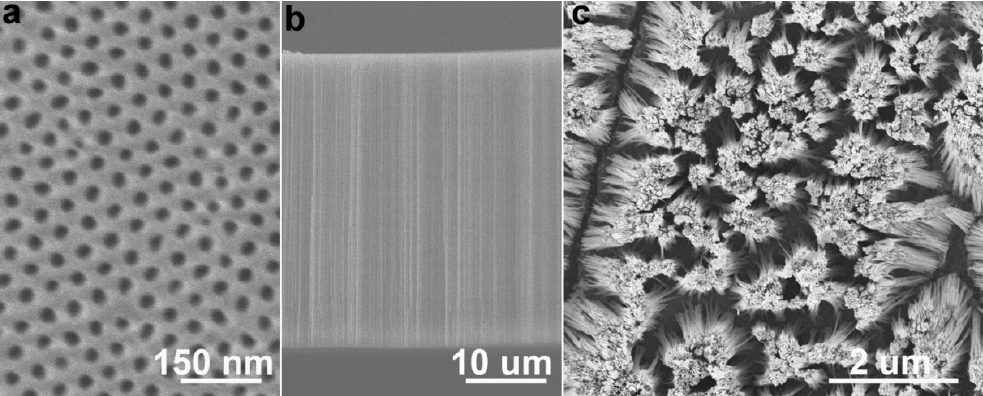
Figure 2. Typical SEM images of a AAO template: ( a ) plan-view, ( b ) view from crossing; ( c ) SEM image of Ni nanowire arrays (current density = 2.5 mA/cm 2 ).